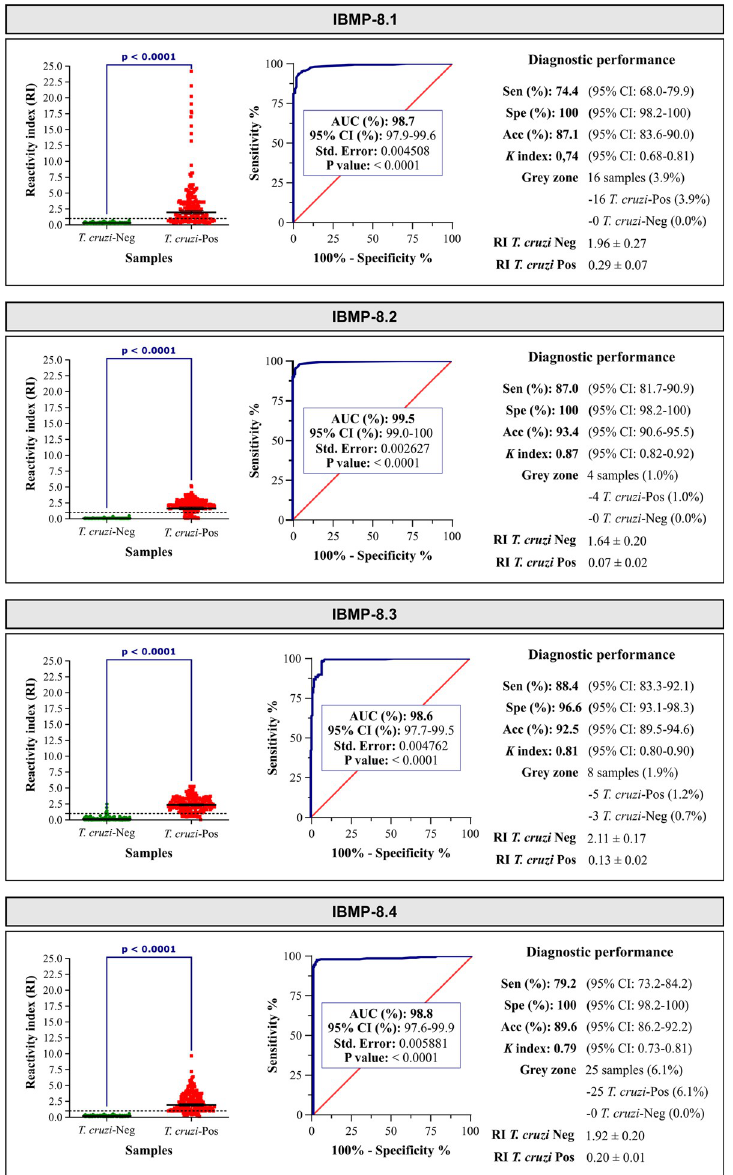
Fig 2. Reactivity Index (RI) and diagnostic performance parameters obtained from Trypanosoma cruzi -positive ( T . cruzi -Pos) and Trypanosoma cruzi -negative ( T . cruzi -Neg) serum samples. The established RI cut-off value was 1.0 (dashed line), with corresponding shaded areas representing grey zones (RI = 1.0 ± 0.10). Solid lines indicate geometric mean RI values and corresponding 95% CI values. AUC (Area Under Curve); Sen (Sensitivity); Spe (Specificity); Acc (Accuracy); K ( Kappa index); CI (Confidence